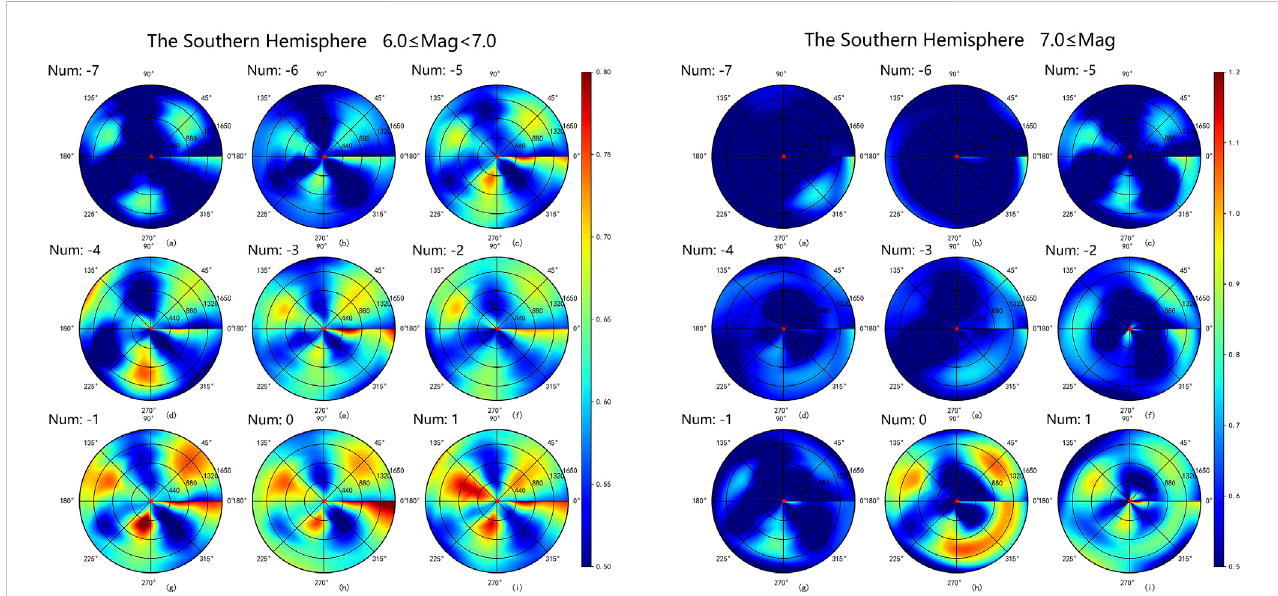
FIGURE 5 Spatial and temporal distribution of spatial electric fi eld ELF band perturbations of magnitude 6.0 – 7.0 and magnitude 7+ earthquakes in the Southern Hemisphere.(Num: − 7toNum: − 1representstheseventhcycletothe fi rstcyclebeforetheearthquake,Num:0istheperiodofearthquake,Num:0isthe fi rst period after the